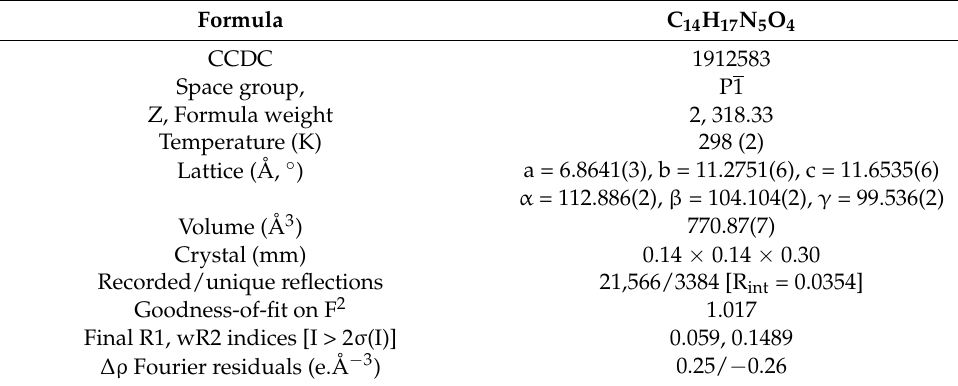
Table 1. Crystal data and structure refinement for C 14 H 17 N 5 O 4 .